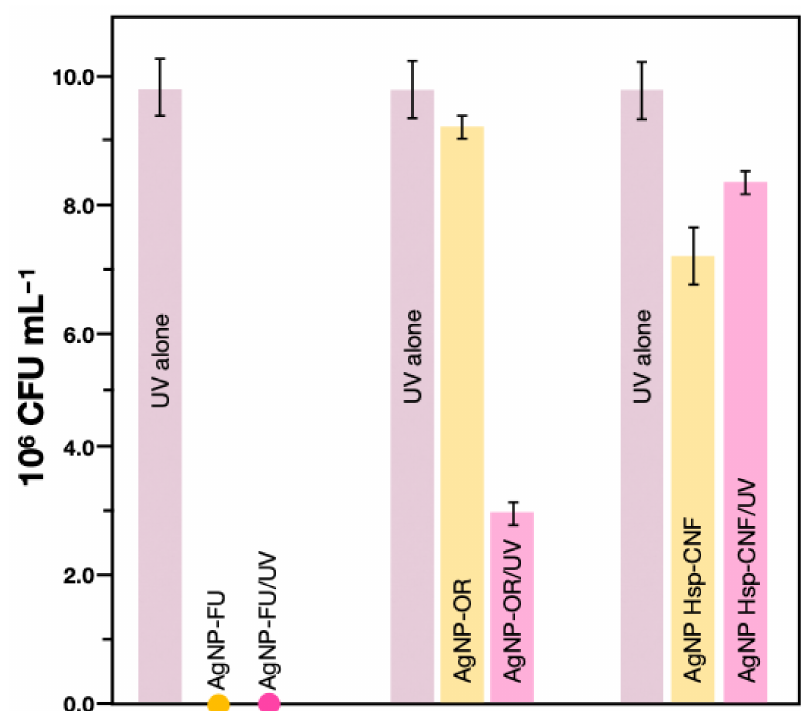
Figure 3. Colony-forming units (CFU × 10 6 per mL) of existing E. coli after exposure to UV radiation for 2 h and/or three biogenic